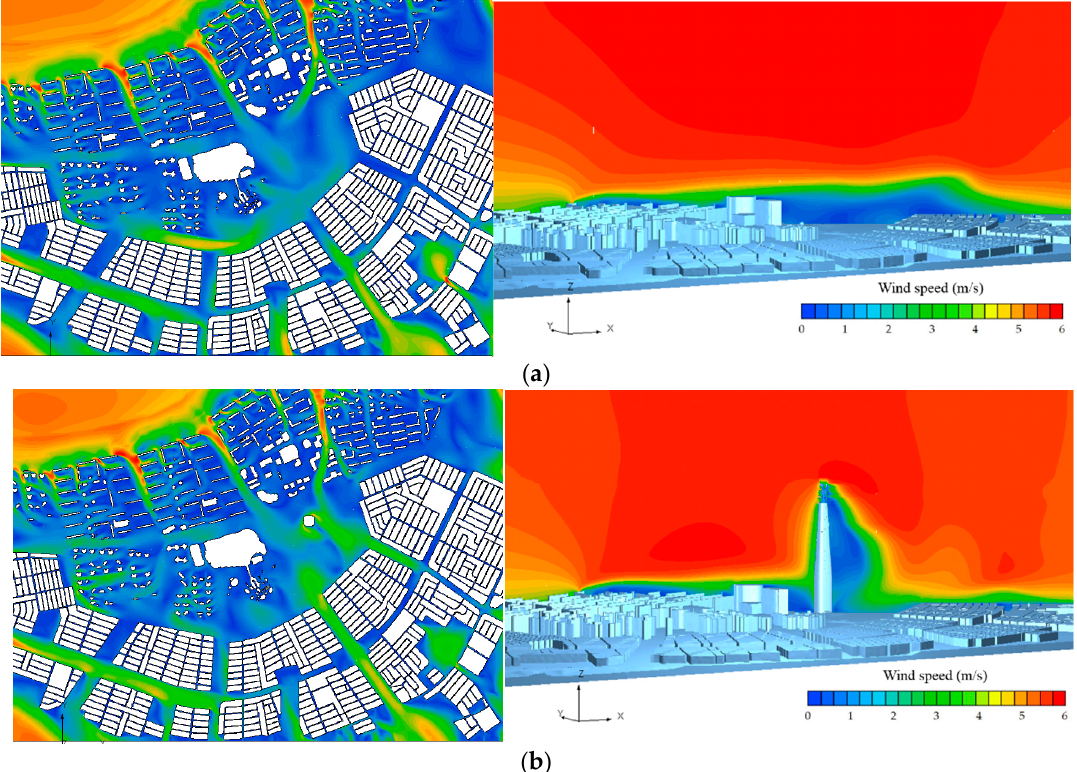
Figure 14. Computation results of pedestrian-level wind speed around the Lotte World Tower: horizontal ( left column ); and vertical ( right column ) cross-sectional wind speed variability: ( a ) without the Tower; and ( b ) with the Tower.